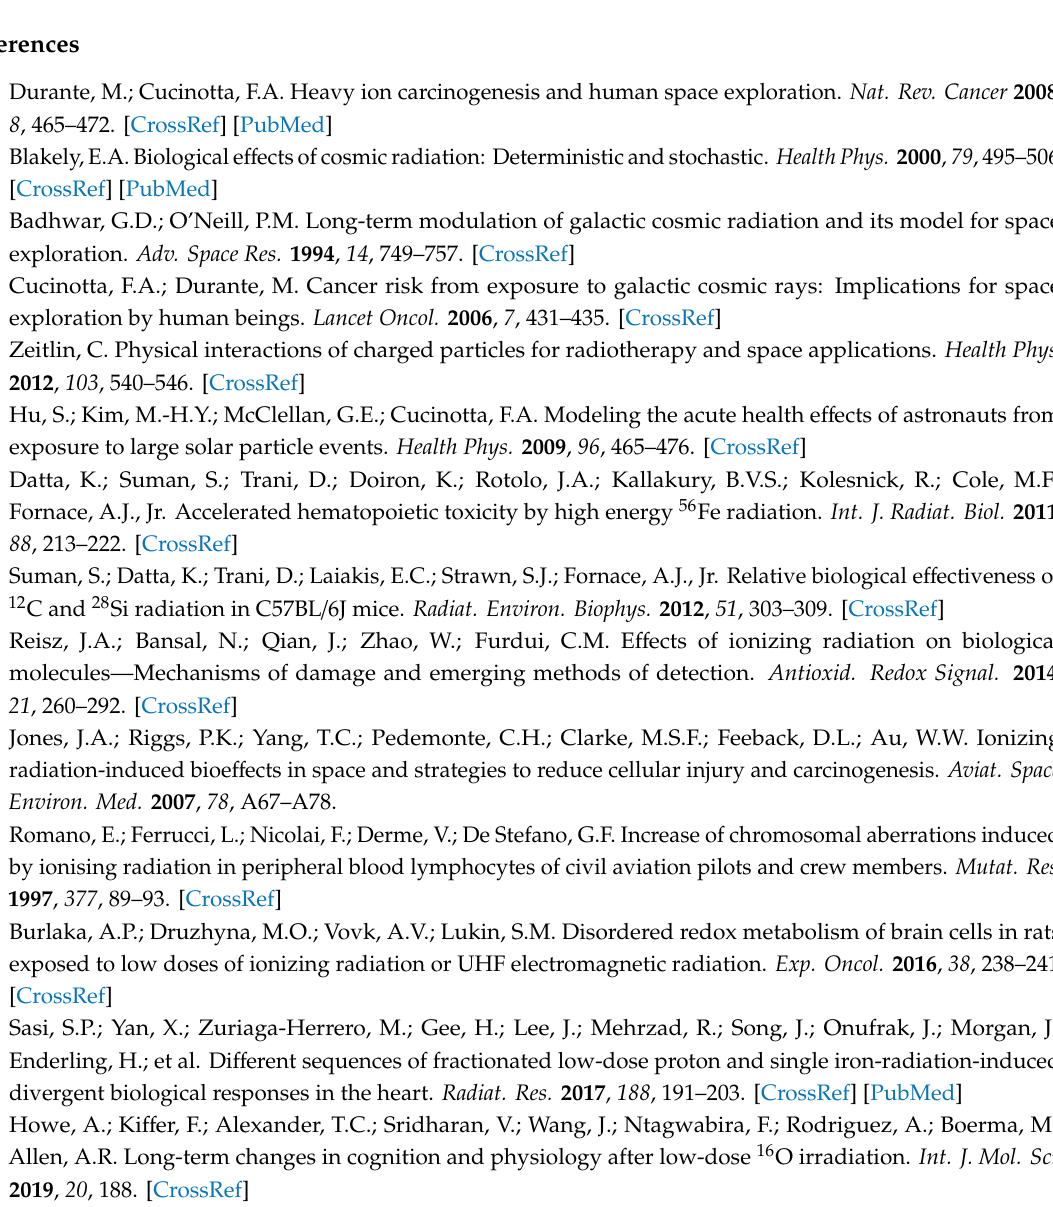
mice plasma, Table S2: List of dysregulated metabolites (ANOVA for all doses) after exposure to 16 O radiation at days 14 and 90 post-irradiation, Table S3: List of dysregulated metabolites (ANOVA for all time points) after exposure to 0.1 Gy, 0.25 Gy or 1 Gy of 16O radiation, Table S4: List of dysregulated metabolites after exposure to 16 O radiation at day 14 (ANOVA_post hoc comparison), Table S5: List of dysregulated metabolites after exposure to 0.5 Gy and 1 Gy of 1H and, 0.5 Gy, 1 Gy and 3 Gy of g radiation (ANOVA for all doses of radiation), Table S6: List of dysregulated metabolites after exposure to radiation at days 14 and 90